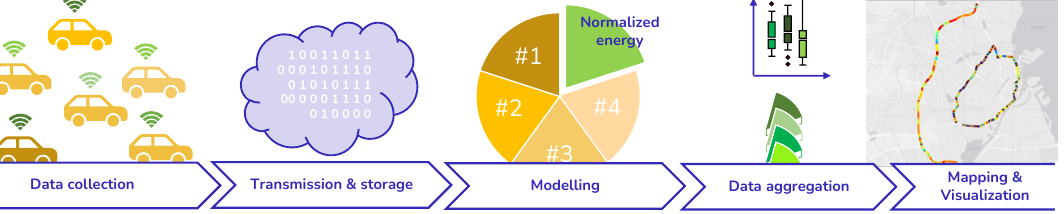
Figure 1. Proposed framework for road energy efficiency monitoring, showing the data collection from vehicle sensors, data transmission, storage, normalization of data utilizing physical models, data aggregation, and mapping and visualization.